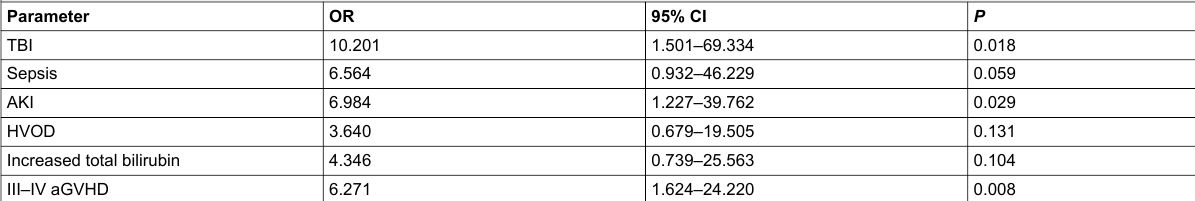
Table 6: Independent risk factors for death in patients after 100 days